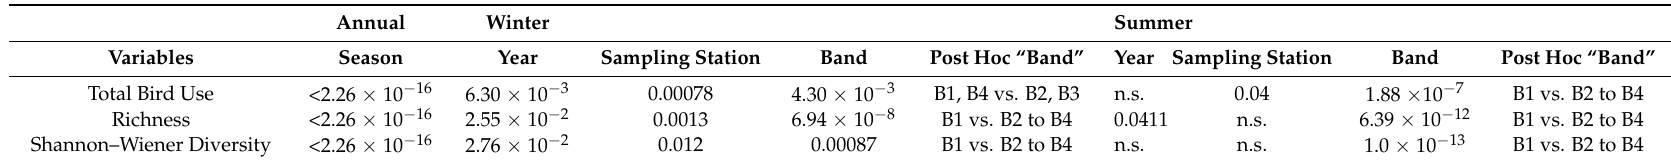
Table 2. p -Values of Kruskall–Wallis and Wilcoxon tests performed on waterbird community indexes in relation to temporal and spatial class variables. The Wilcoxon test was conducted for factors with only two classes: “season” (summer/winter) and “year” (only for the summer waterbird community, sampled twice). Kruskall–Wallis test was conducted for factors with more than classes: “station” and “band” in both seasons, and “year” (for the wintering waterbird community, sampled four times). n.s. =